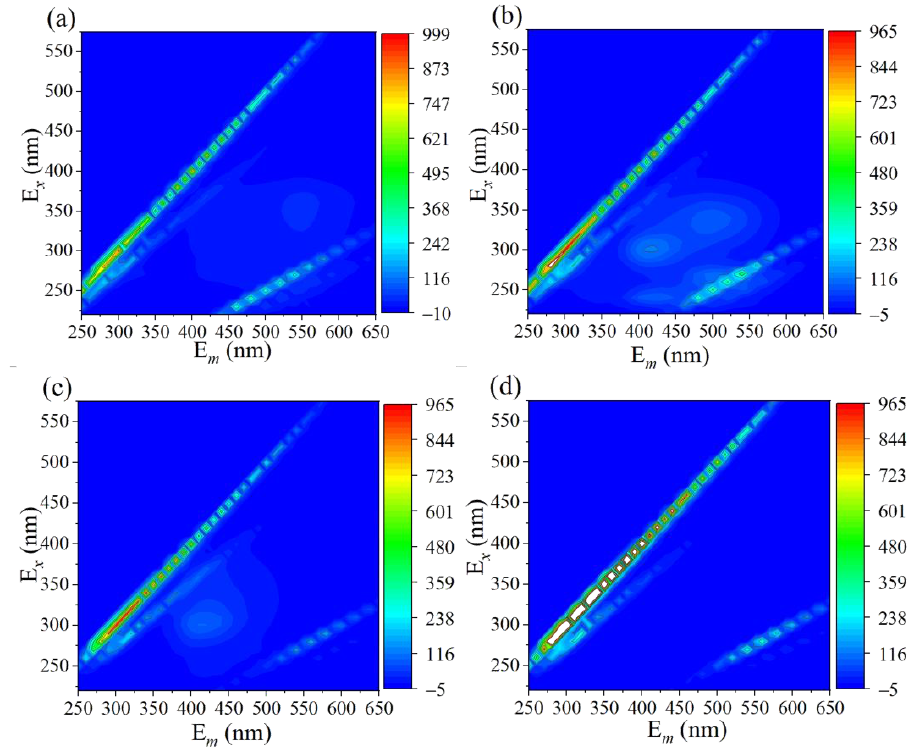
Figure 5. Three-dimensional EEM fluorescence spectra of TC solution after ( a ) 0 min, ( b ) 30 min, ( c ) 60 min, and ( d ) 24 h during the reaction.